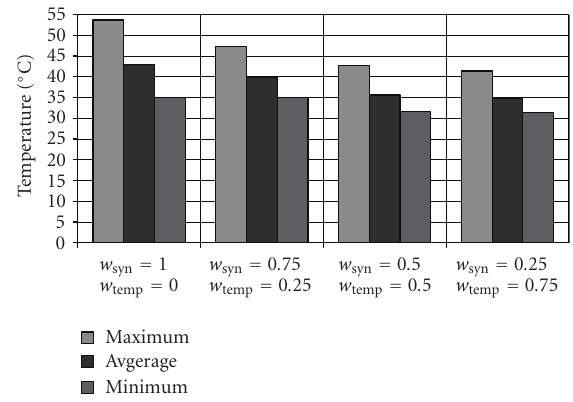
Figure 9: Maximum (Max), average (Avg), and minimum (Min) temperatures for the game-theoretic solution for 4 weight